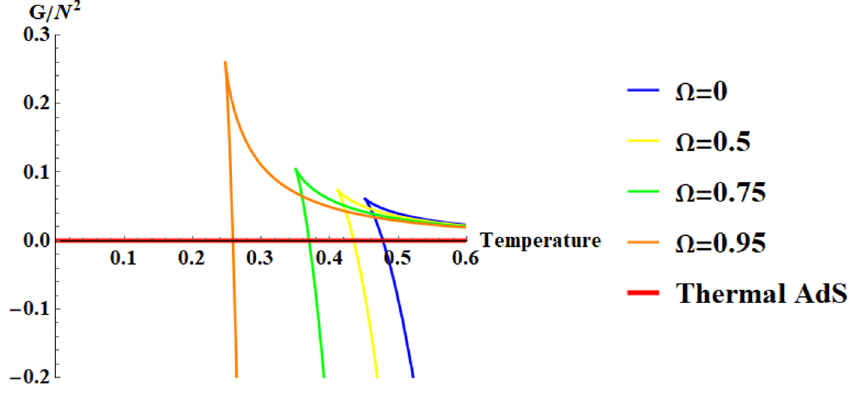
= Ω = 0 , 0 . 5 , 0 . 75 , 0 . 95 . The a b